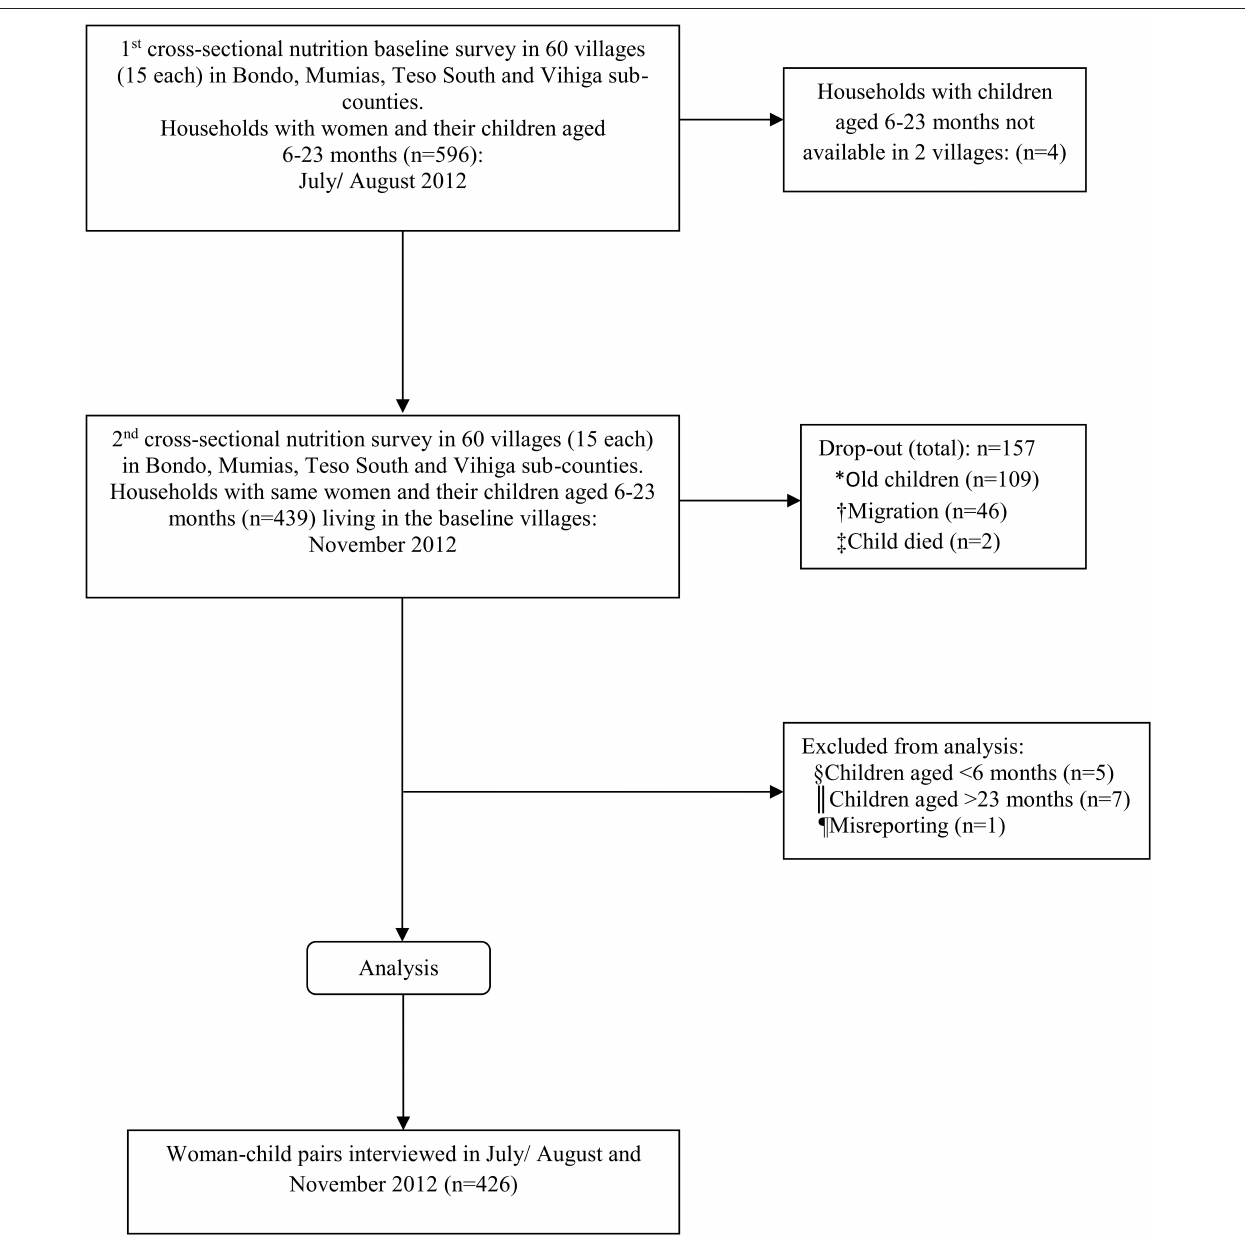
FIGURE 1 | Study profile. *old children: the children were aged above the required 23 months; † migration: sample households relocated from study area; ‡child died: the sampled children had passed away; §child < 6 months: age of children less than the required age of 6 months; ||age of children above the required age of 23 months; ¶Misreporting: Missing